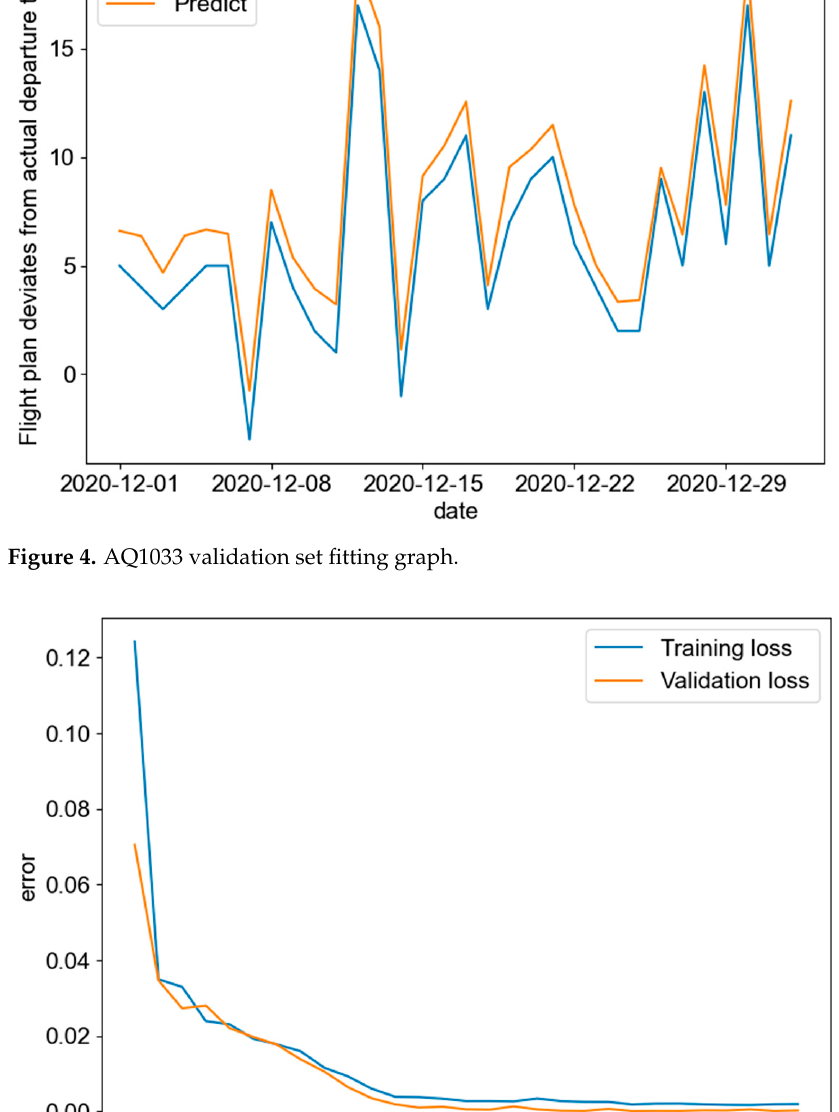
Figure 4. AQ1033 validation set fitting graph.